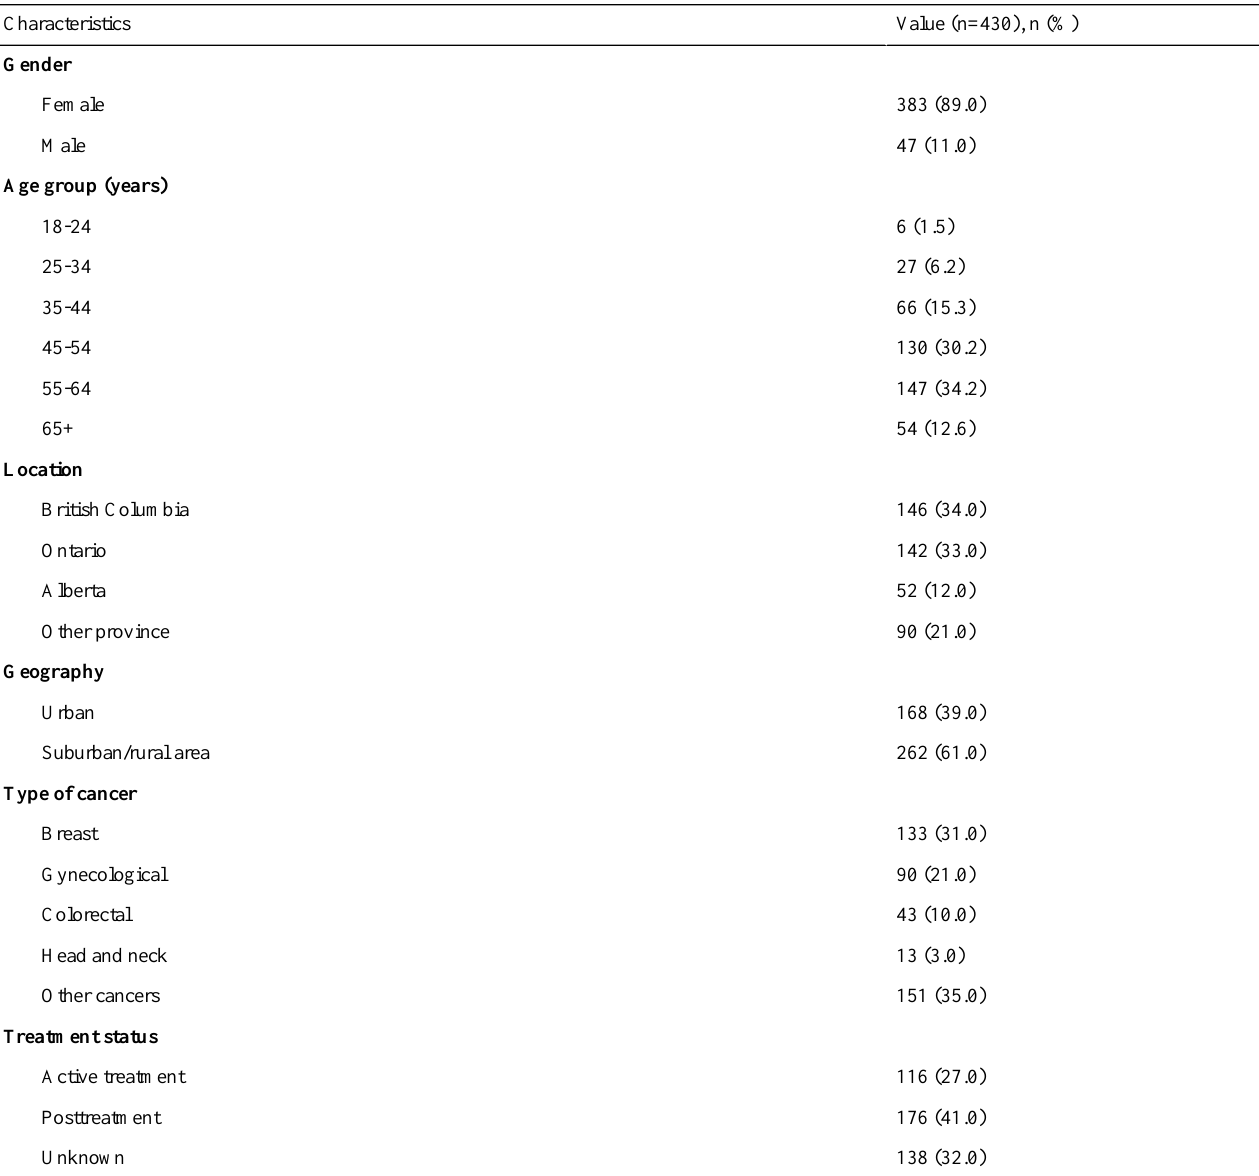
Table 1. CCC participant